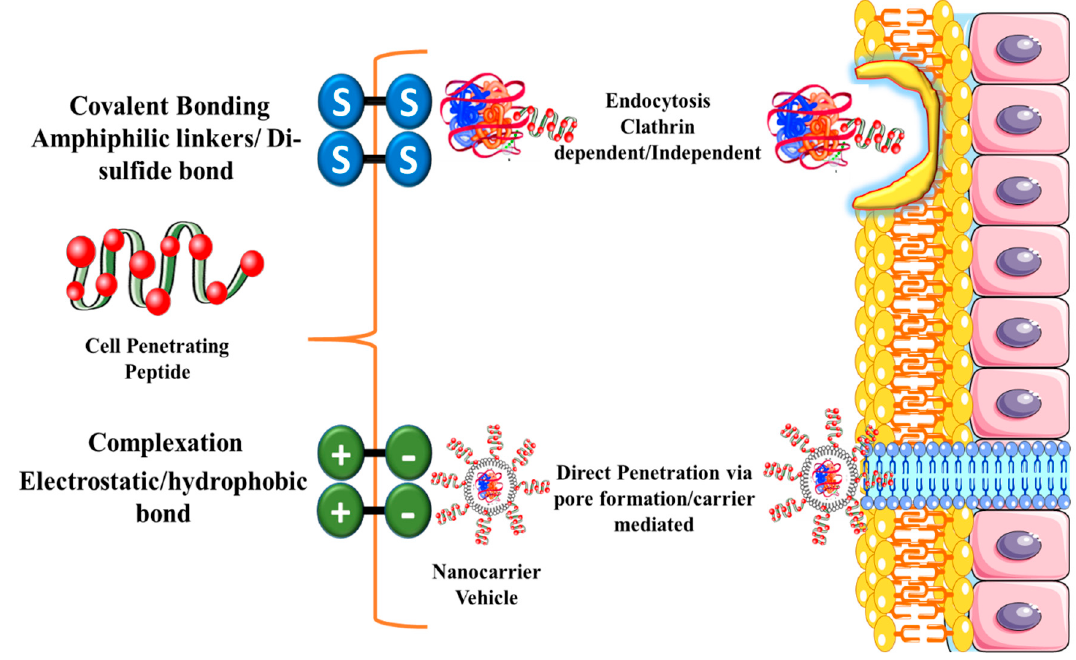
Figure 4. Conjugation and uptake mechanism of Cell-Penetrating Peptide mediated TPPs. Cell- Penetrating Peptides can be conjugated to the TPP either via covalent bonding using amphiphilic linkers, disulfide bonding, or by complexation using electrostatic interactions, hydrophobic bonding. Cell-Penetrating Peptides are up taken generally by two mechanisms (endocytosis or direct penetration via pore